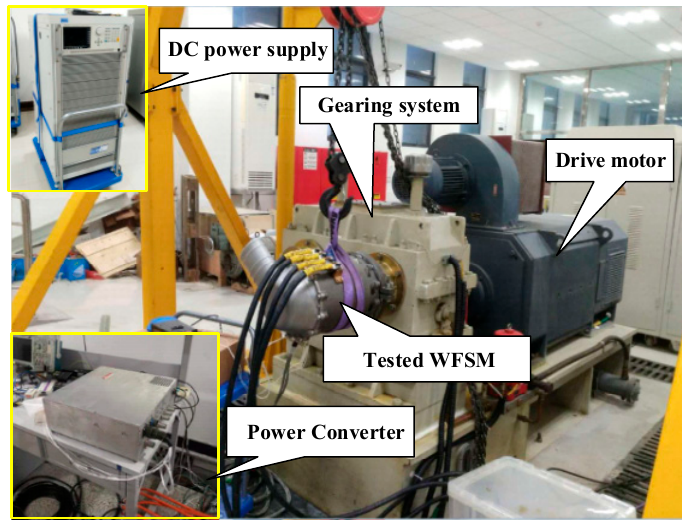
Figure 19. WFSM test